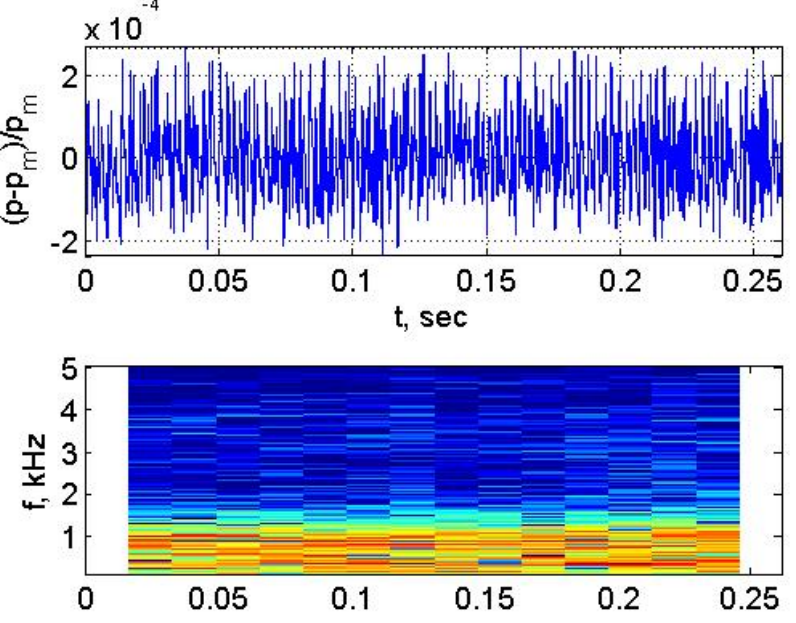
Figure 12. Spectrogram (bottom plot) of the near-field pressure signal (top plot) producing the spectrum in Figure 11. (Adapted from [14]).